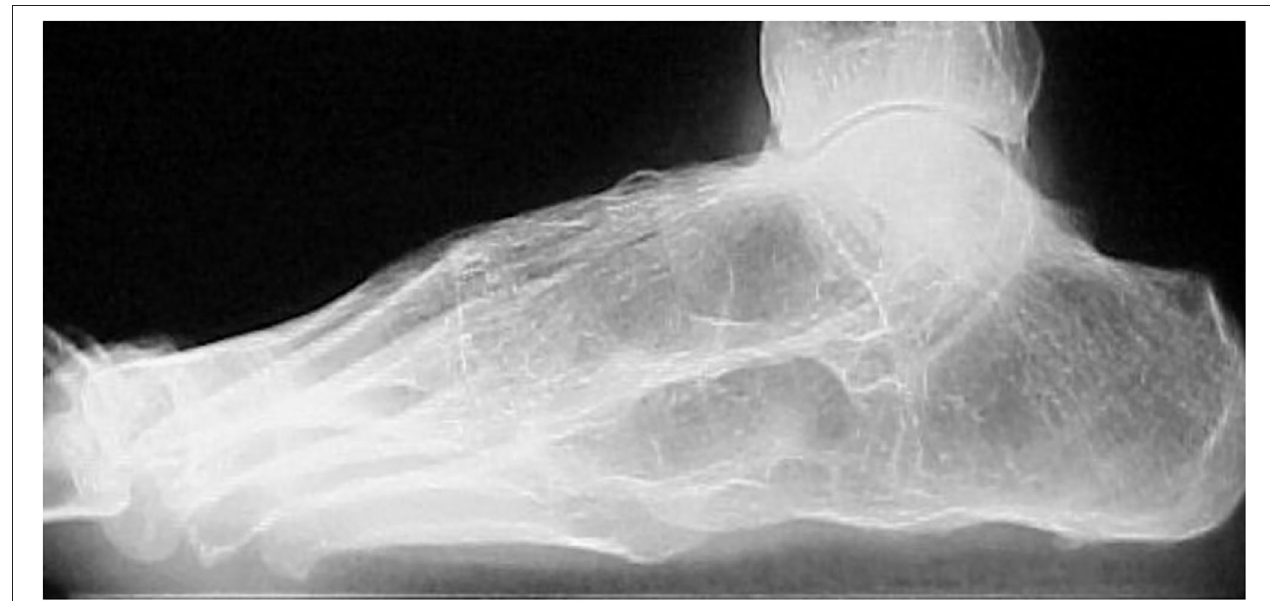
FIGURE 2 | Chronic changes in a patient with JoSpA. Lateral view showing complete tarsal ankylosis and plantar enthesophytosis. Courtesy of Dr. Rubén Burgos-Vargas.